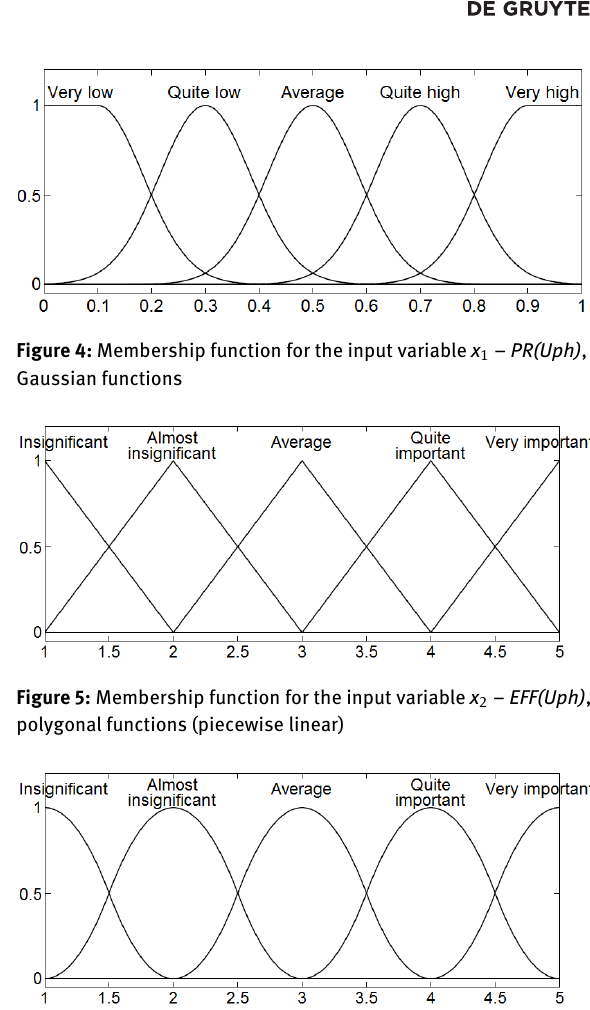
Figure 6: Membership function for the input variable x 2 – EFF(Uph) , complex functions (linear quadratic)